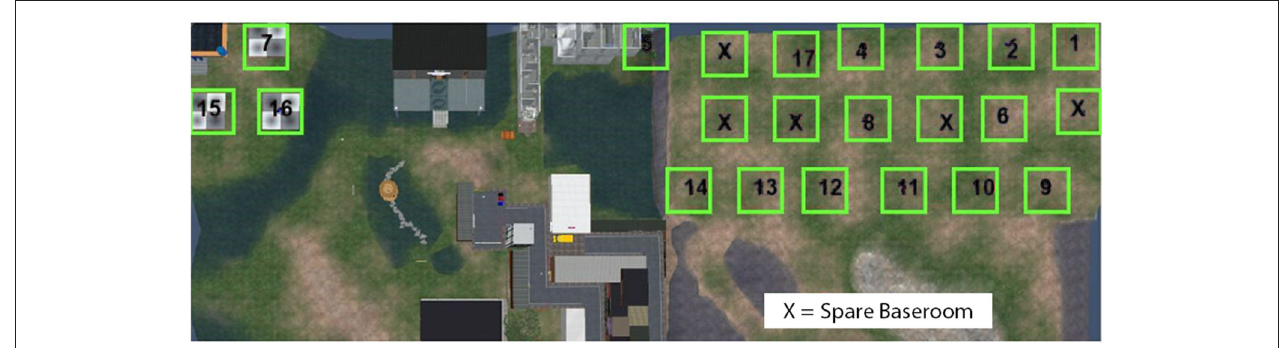
FIGURE 6 | Second life Island plan of which real life baserooms will be located in which virtual baseroom. This plan was used by the development team to keep track of all rooms and to ensure there was no crossover between